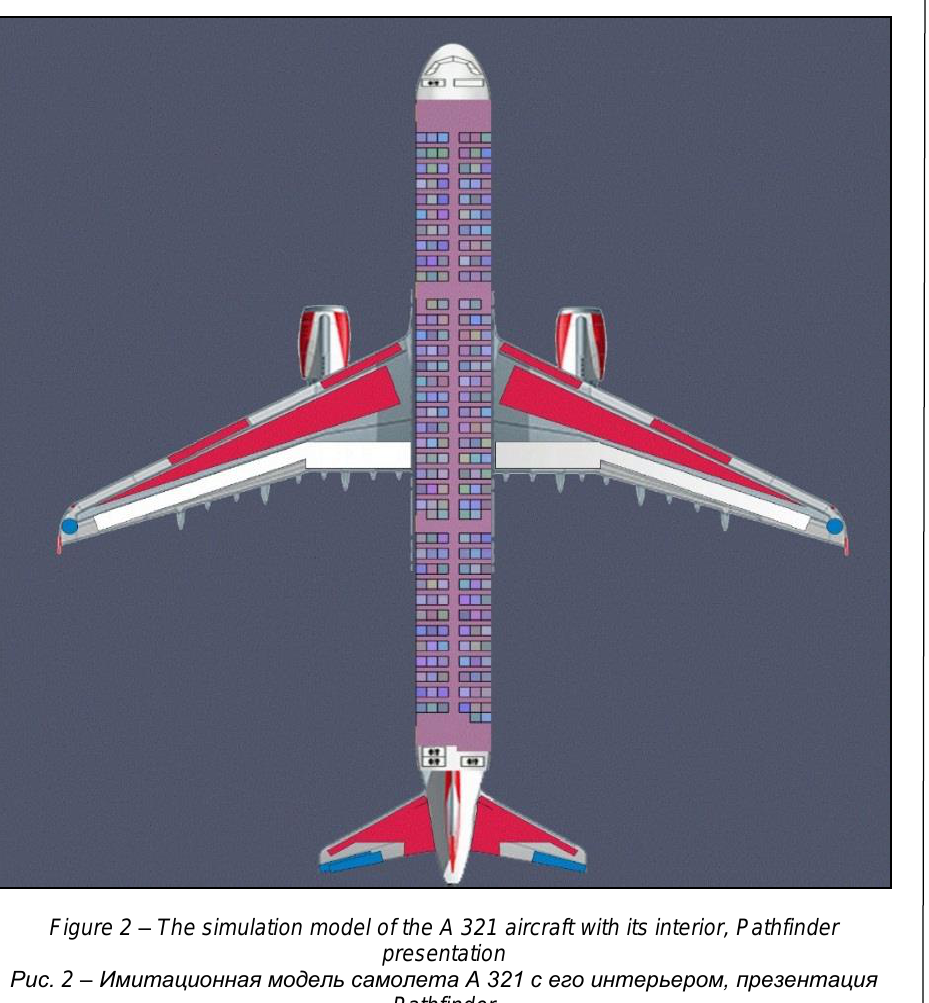
Figure 2 – The simulation model of the A 321 aircraft with its interior, Pathfinder